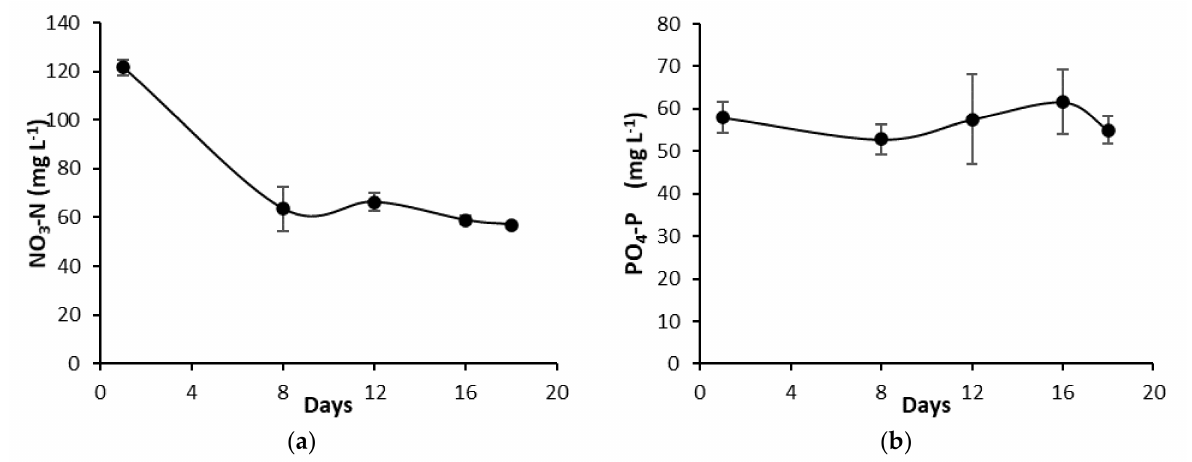
Figure 3. Concentration of ( a ) NO 3 -N and ( b ) PO 4 -P in the organic nutrient solution over the experimental period. Statistically significant differences are indicated by different